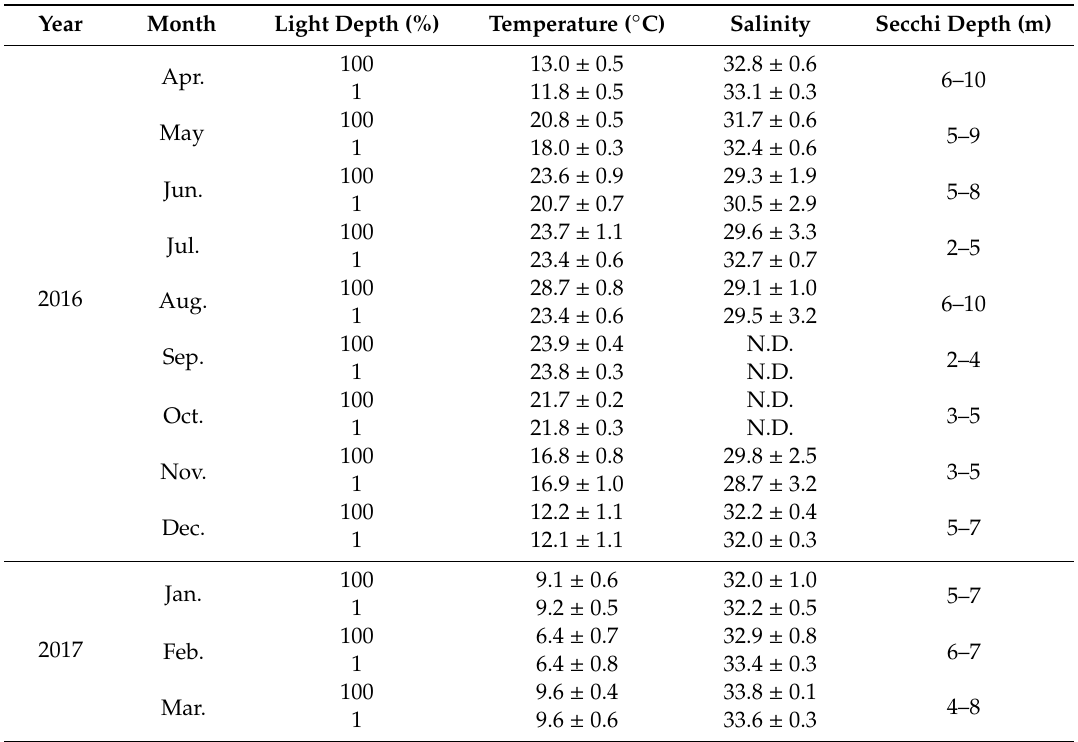
Table 1. Station-averaged environmental variables observed at the sampling stations in Jaran Bay. N.D. means no